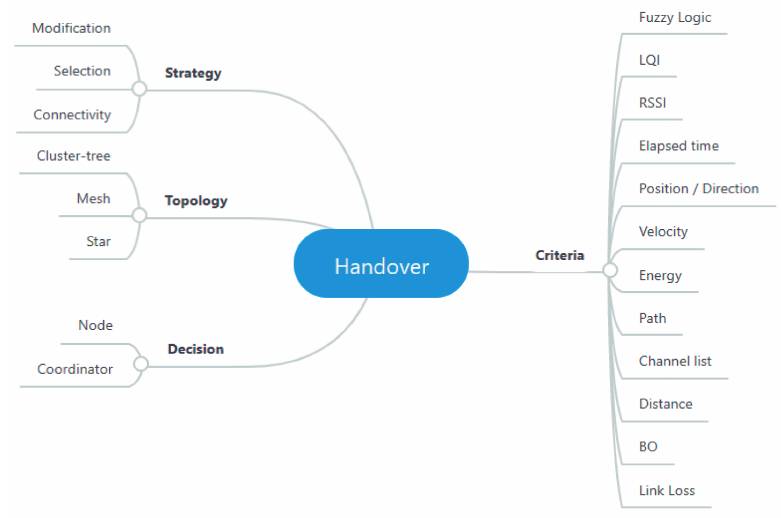
Figure 1. Improvements in the association